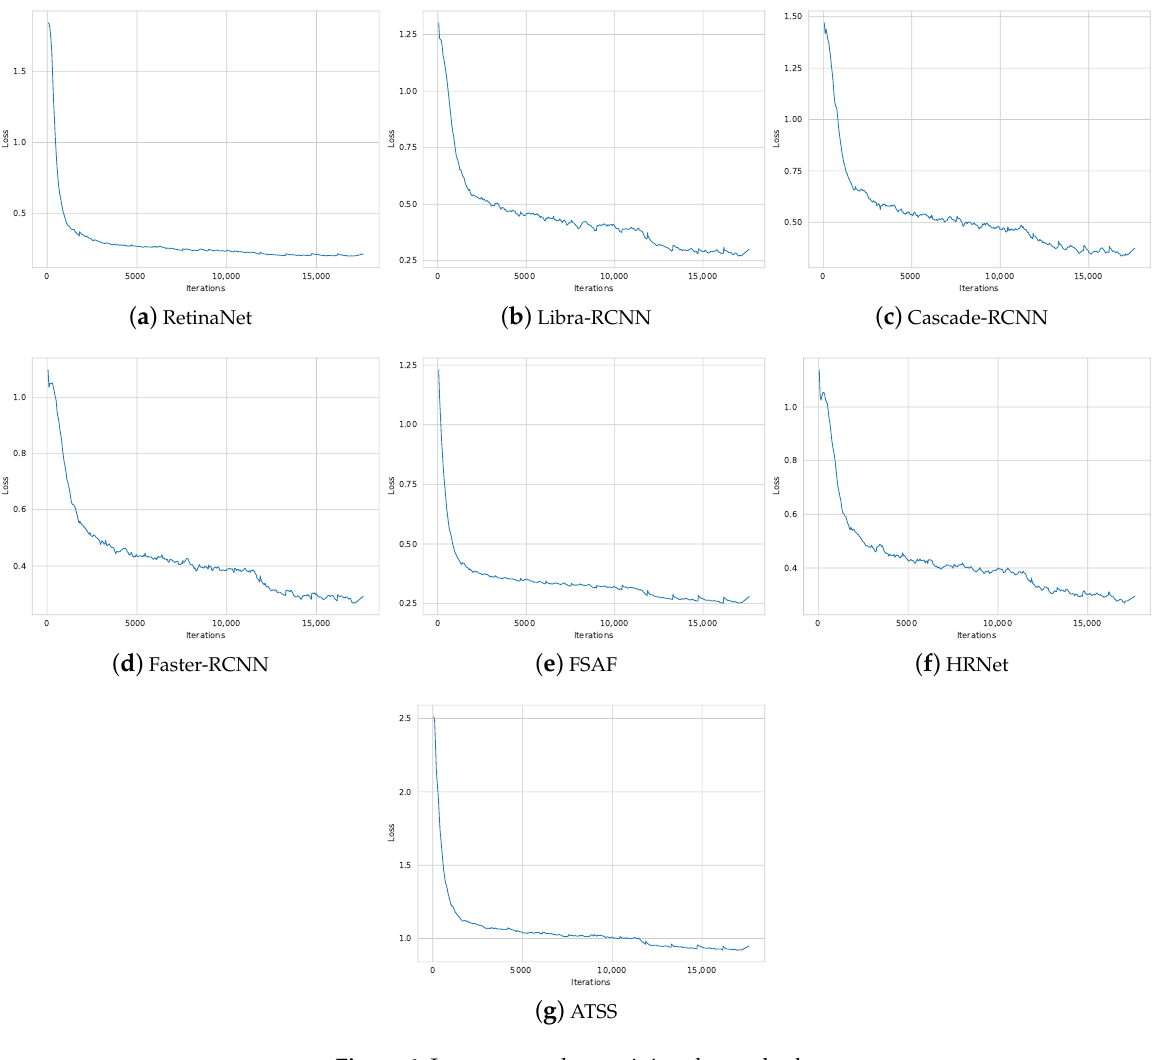
Figure 6. Loss curve when training the